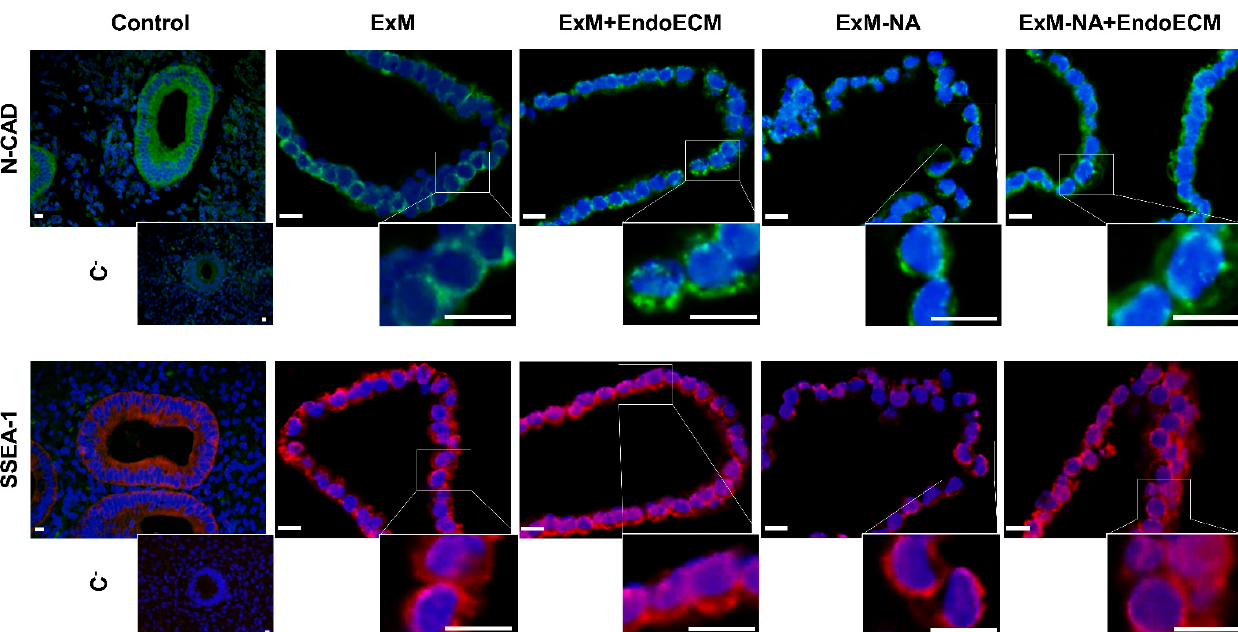
Figure 7. Epithelial progenitor cell markers in human endometrial organoids. N-cadherin (green) and SSEA-1 (red) expressions in positive controls (human endometrium) and human endometrial organoids cultured in the four different experimental conditions: ExM, ExM+EndoECM, ExM-NA, ExM-NA+EndoECM. A higher magnification of the boxed areas is shown in all panels. Cell’s nuclei stained with DAPI. Scale bars are 10 μ m.